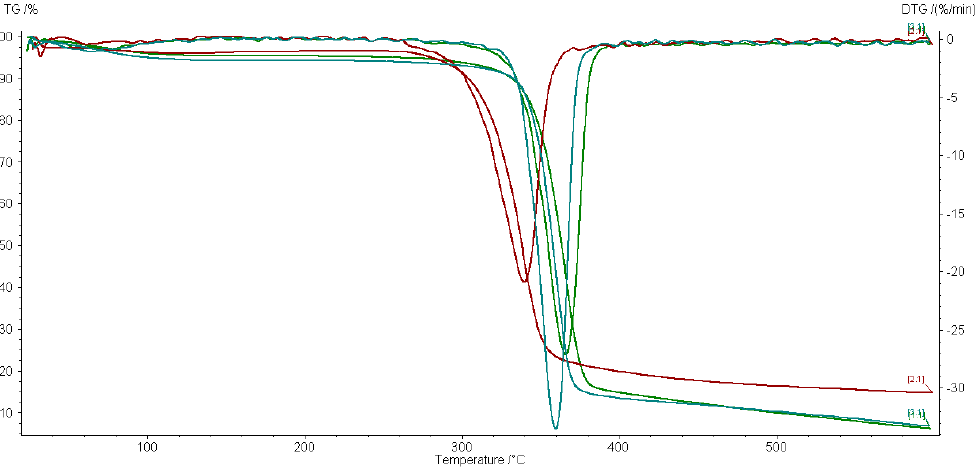
Figure 2. TG/DTG data of cotton impregnated with Ag/C (green lines), Ag/PVP (red lines), and ZnO/PVP (blue lines) and irradiated at 5 kGy in a dry state.